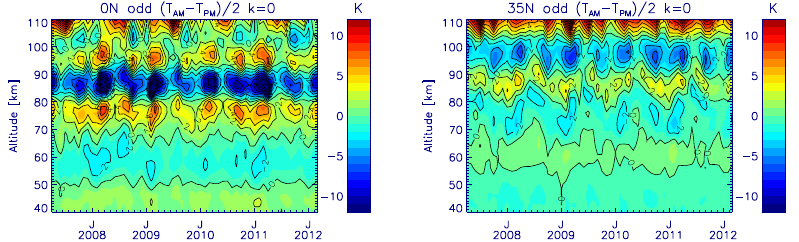
Figure 13. Time series of the MIPAS zonal mean of (cid:49)T/ 2 monthly means ( | n odd − s | = 0 mode) at the Equator (left) and over 35 ◦ N (right).